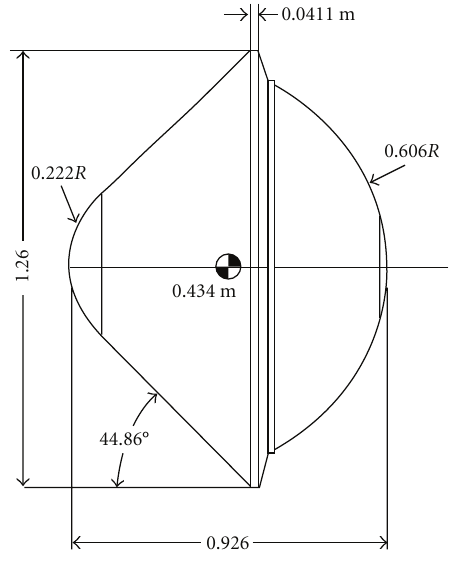
Figure 19: Galileo probe.